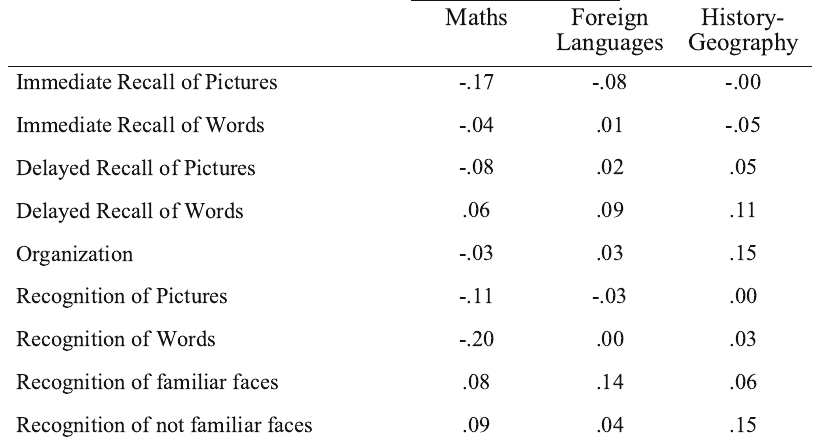
Correlations between Scores of memory (SM9)and school averages in three subjects in middle school students (average age : 17 years; n =